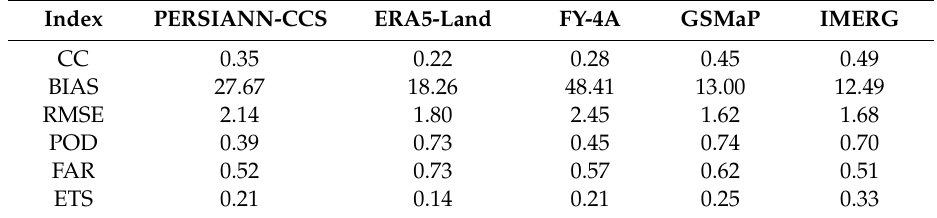
Table 5. Averaged statistical indices for PERSIANN-CCS, ERA5-Land, FY-4A, GSMaP, and IMERG at hourly scale over southern China in summer